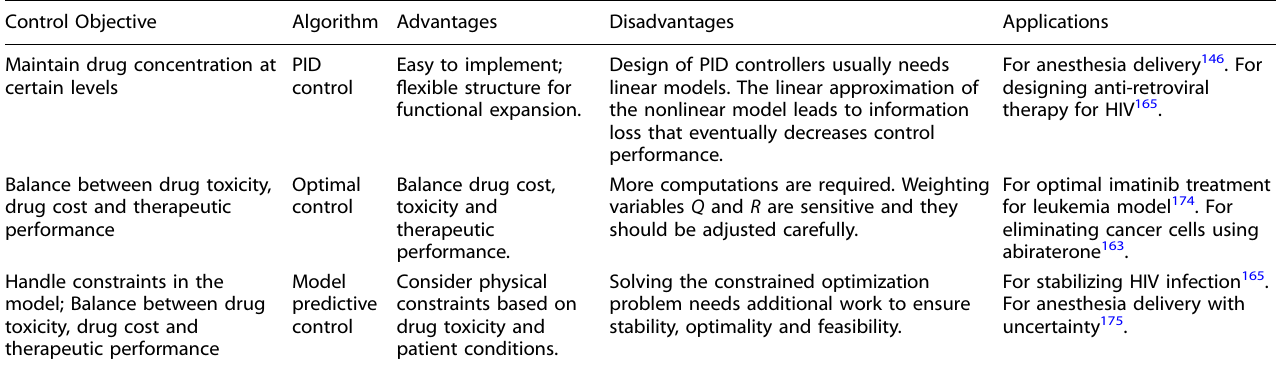
Table 5. Control algorithms for drug